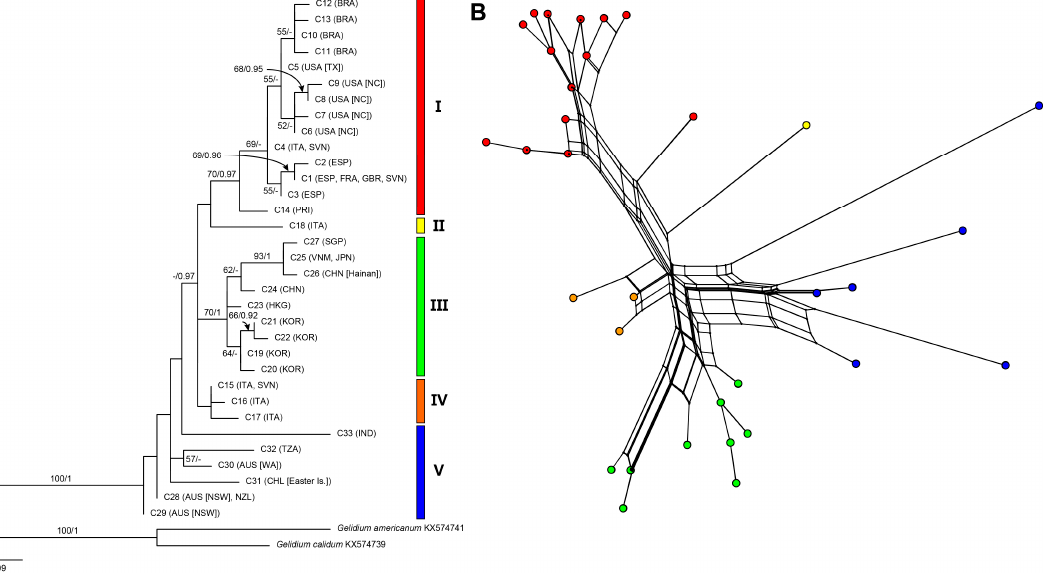
Figure 1. Maximum likelihood (ML) phylogeny ( A ) and split network ( B ) of Gelidium crinale using 33 unique mitochondrial COI-5P sequences. ML bootstrap values ( ≥ 50%) and Bayesian posterior probabilities ( ≥ 0.9) are shown at branches. Dash indicates values <50 or <0.9.